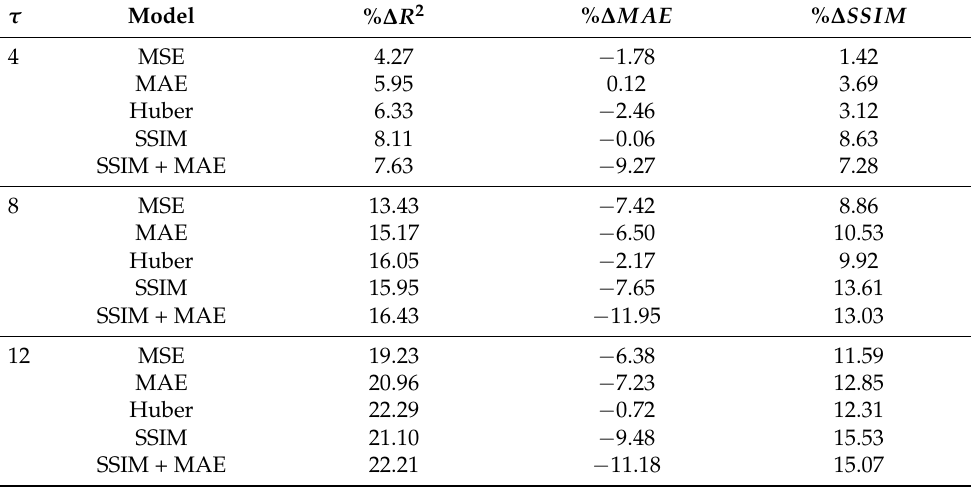
Table 2. Average percentage differences in accuracy metrics of ConvGRU predictions against the optical flow ensemble baseline, grouped by lead time ( τ